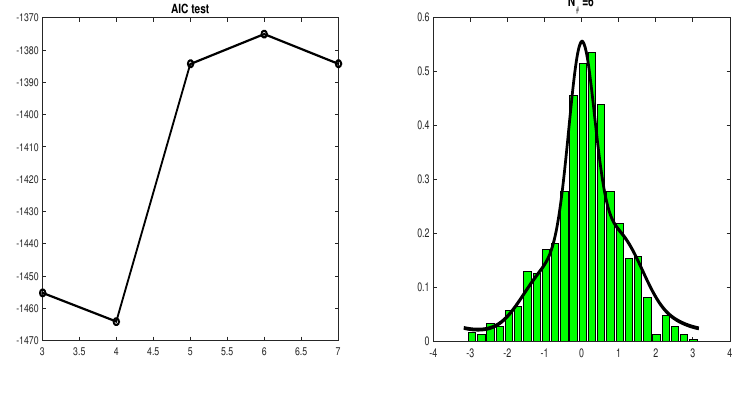
Figure 7. Left, AIC for the maximum likelihood estimate as a function of parameters for the DAX data (left). Right density for the maximum-likelihood fit with N Θ = 6 basis functions, corresponding to the maximal